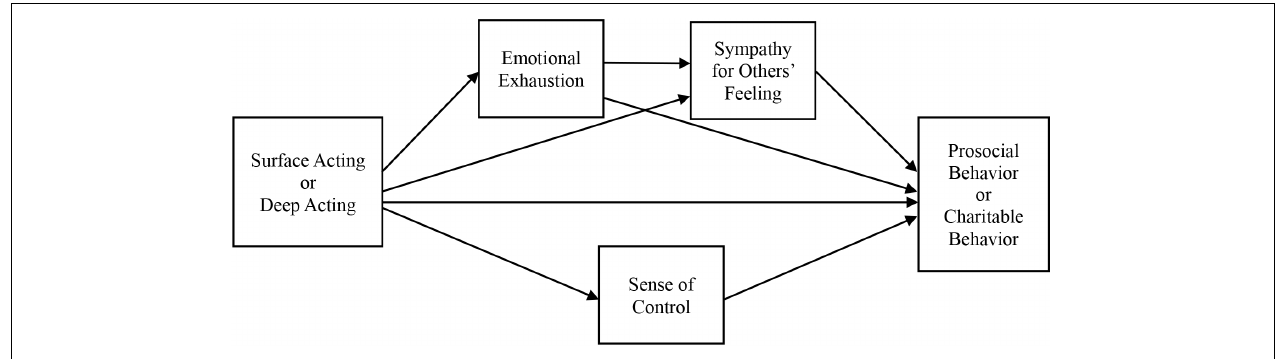
FIGURE 3 | Alternative model configurations for Study